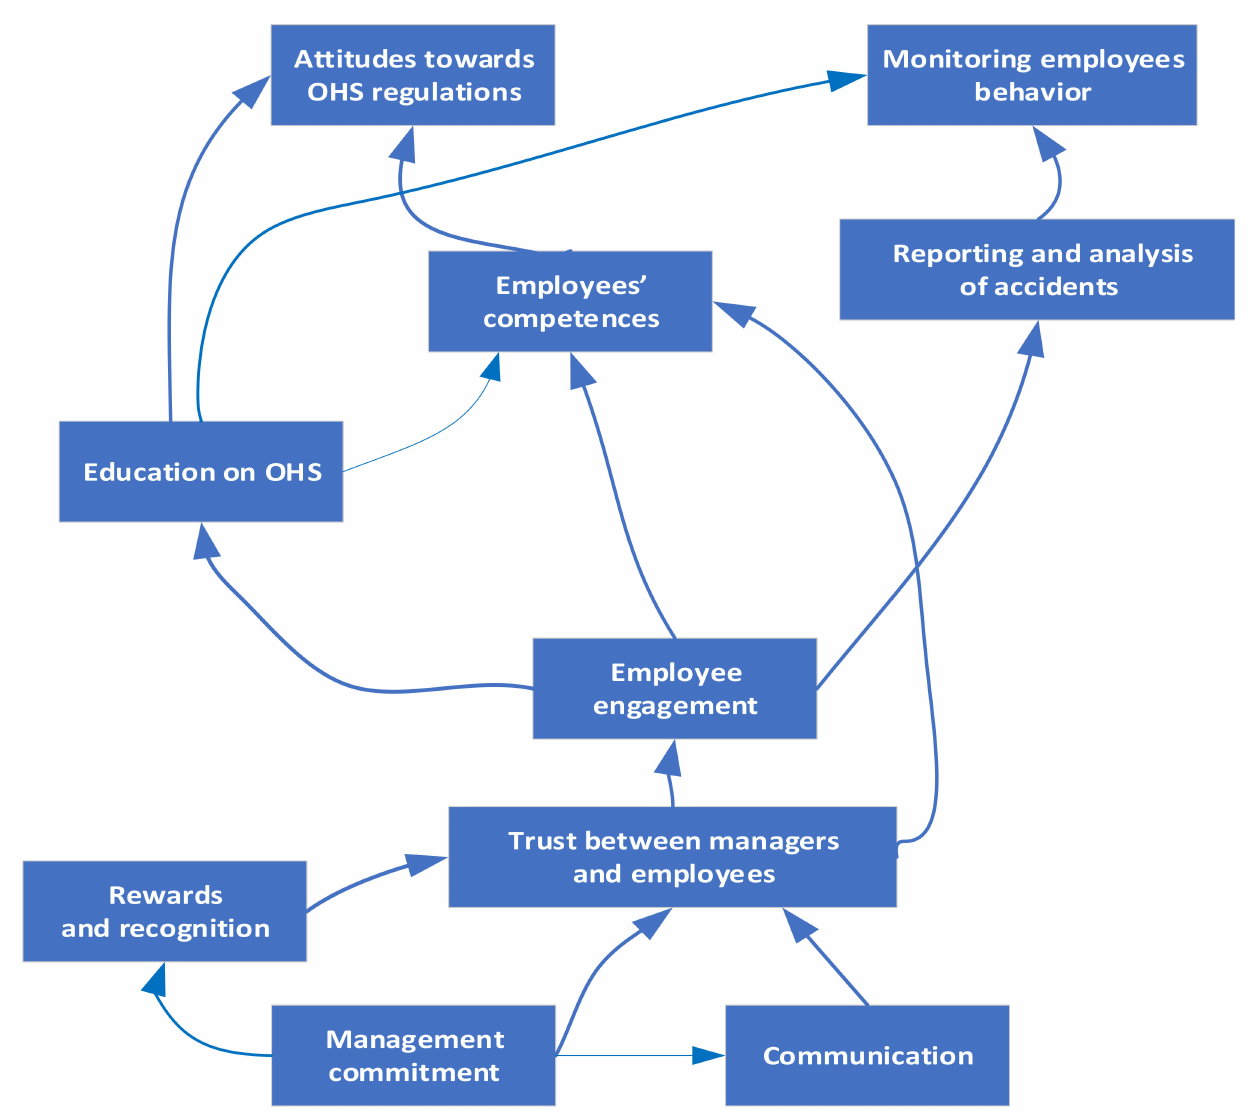
Figure 2. ISM model of the safety culture